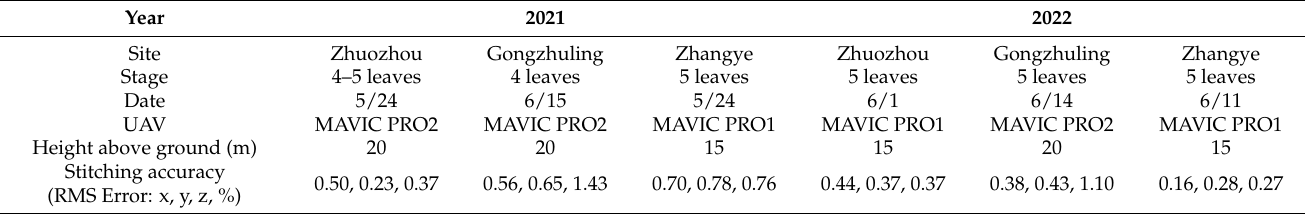
Table 2. The detailed parameters of the unmanned aerial vehicle system (UAV) at different stations during 2021–2022.